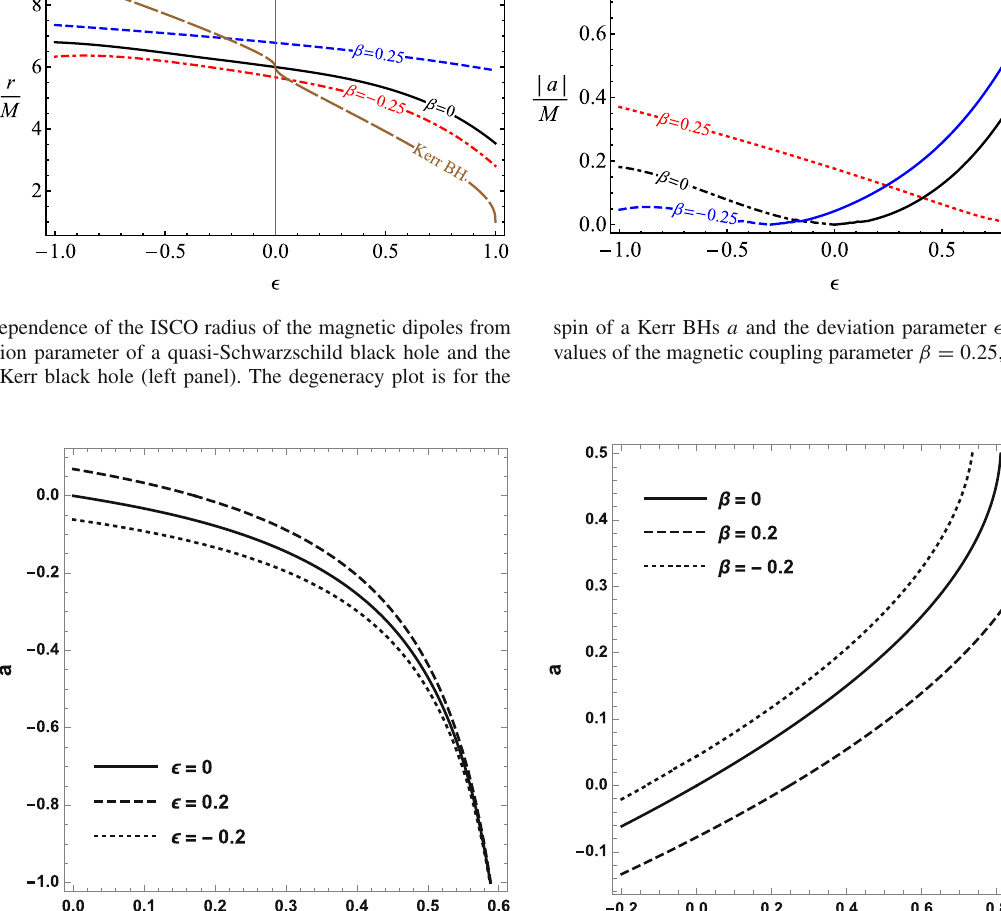
Fig. 10 DegeneracyplotbetweendimensionlessspinoftheKerrBHs a andthemagneticcouplingparameter β anddeviationparameter (cid:2) providing the same value for the ISCO radius for magnetic dipoles around the Schwarzschild black hole immersed in an external asymptotically uniform magnetic